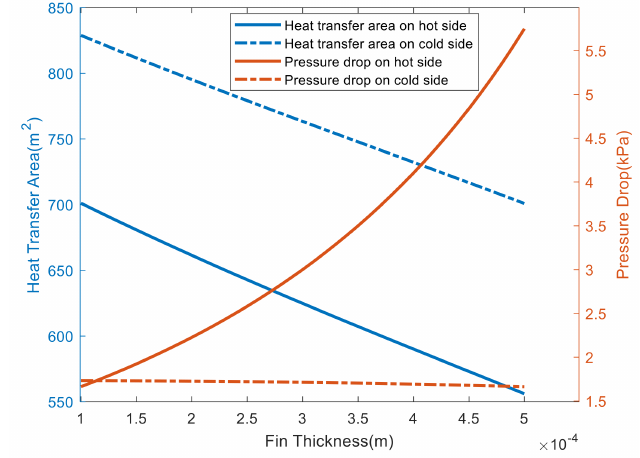
Figure 10. Effect of fin thickness on heat transfer area and pressure drop of